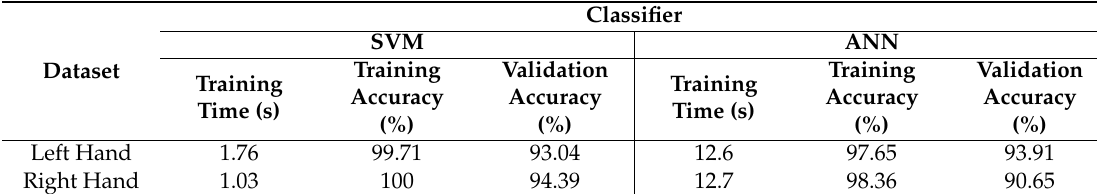
Table 2. Training and validation set accuracies for different datasets (generalized category).